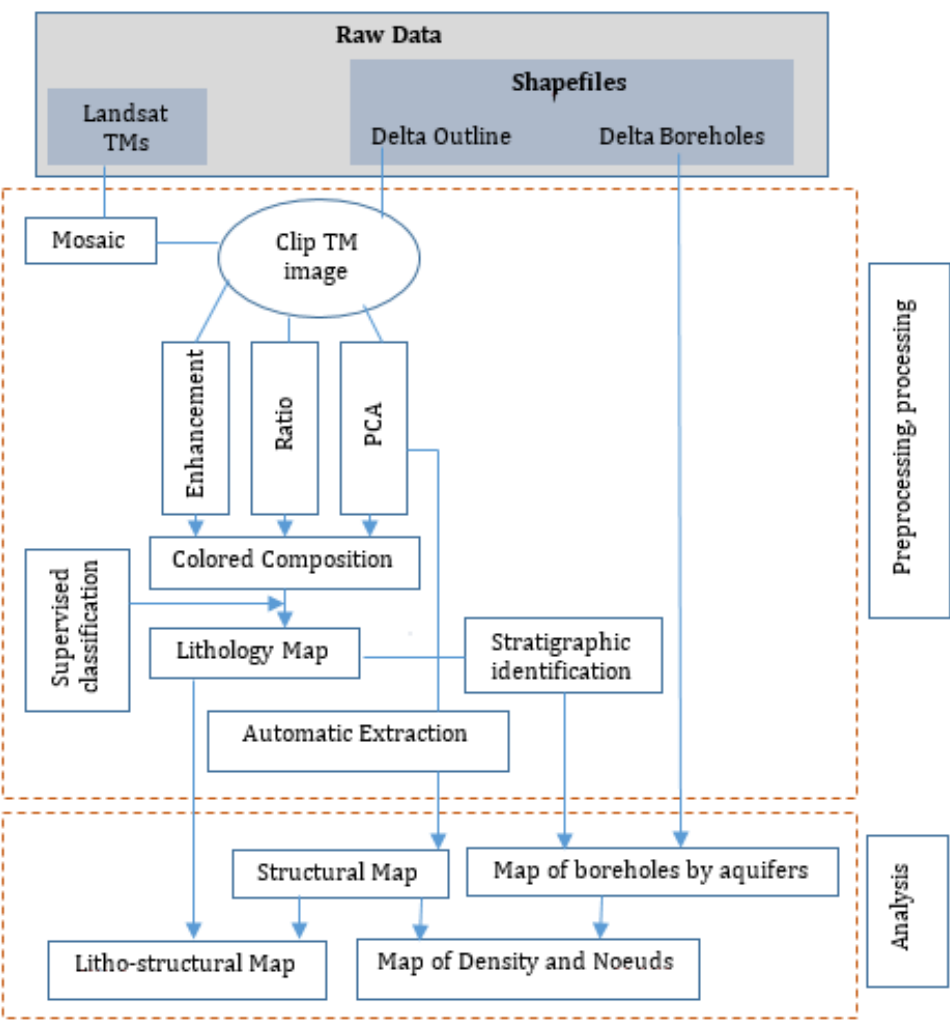
Figure 2. Flow diagram of Study.